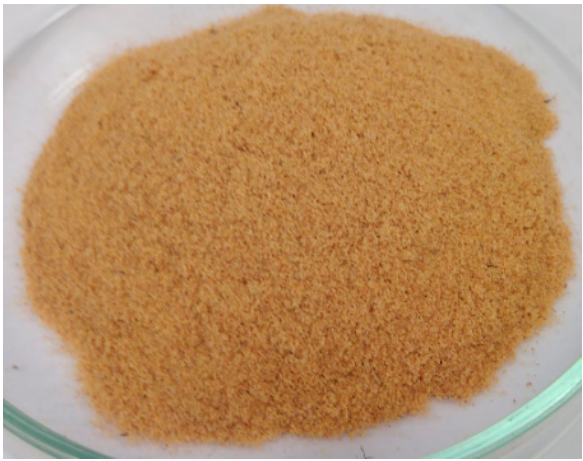
Figure 1. Experimental dust samples.